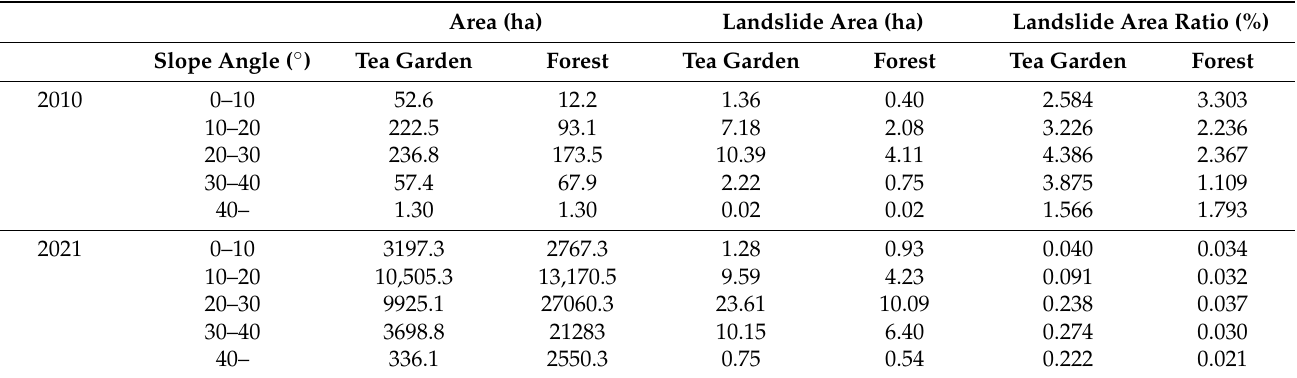
Table 6. Landslides and slope angles in each land use area in 2010 and in 2021. Area (ha) Landslide Area (ha) Landslide Area Ratio